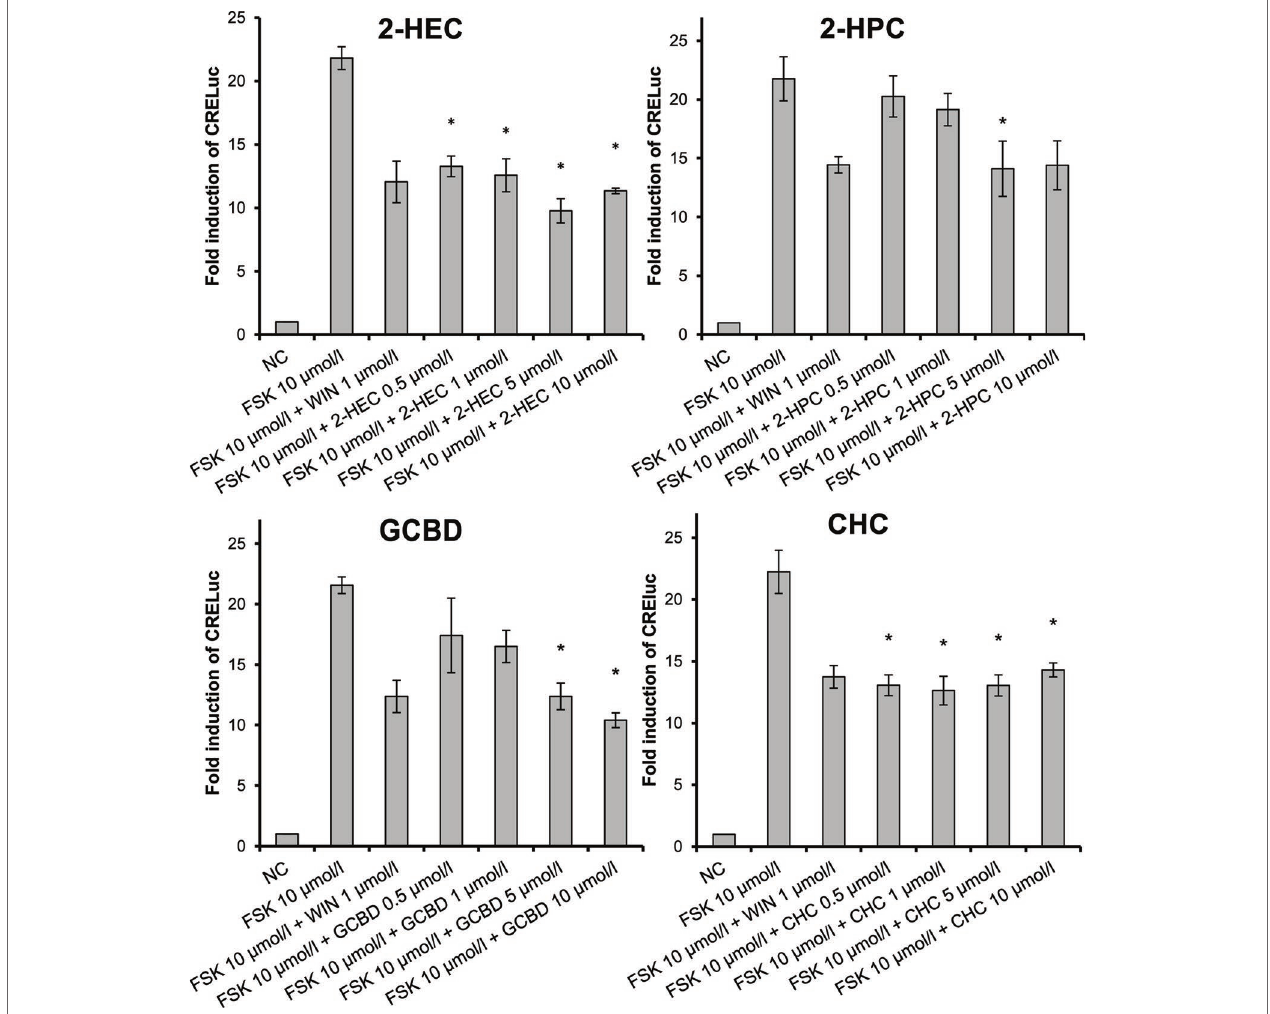
FigURE 1 | CB2‑receptor‑mediated agonistic effects given as fold induction of CRE‑luc; CB, cannabinoid; NC, negative control; FSK, forskolin; WIN, WIN 55212‑2; error bars represent SEM, * p < 0.1.